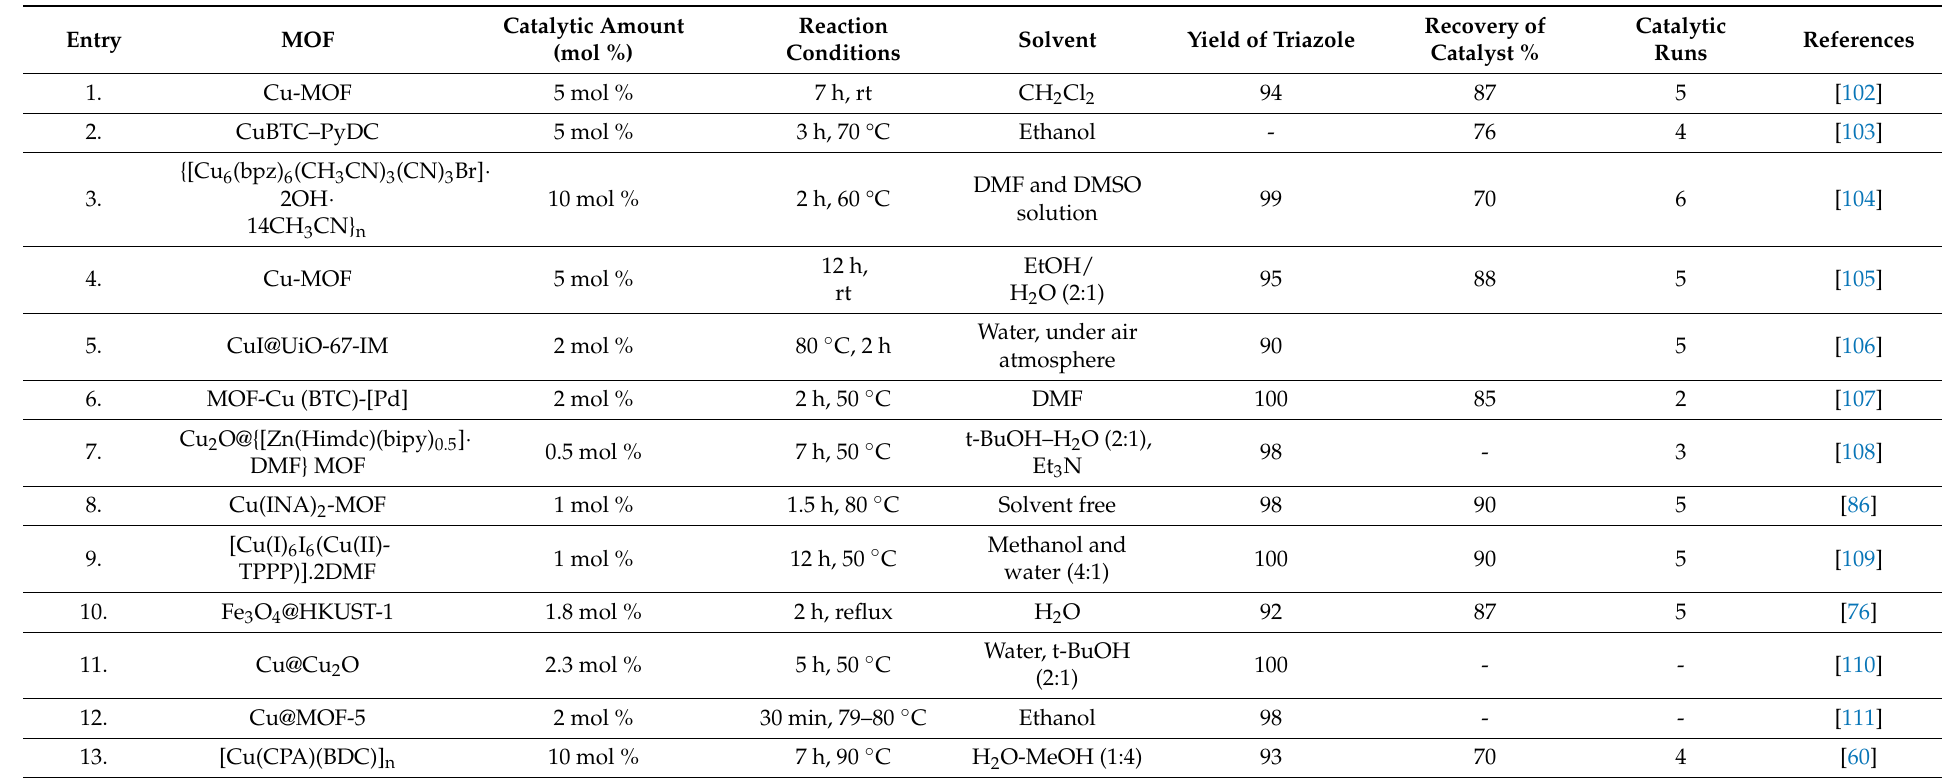
Table 5. Copper-based MOFs for the synthesis of 1,2,3-triazole via CuAAC